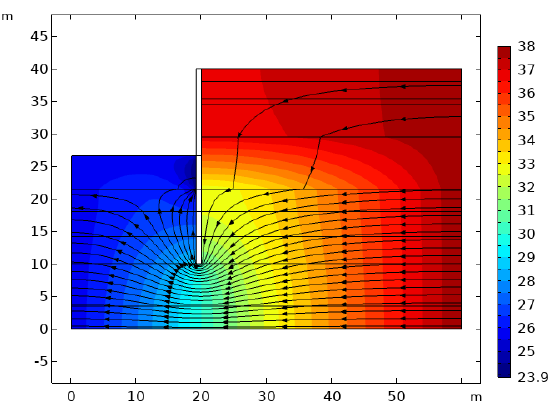
Figure 10. Settlement of different permeability coefficients without waterproof curtain.